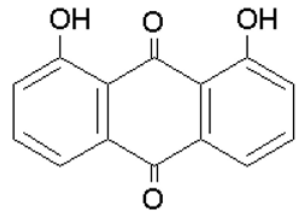
Figure 5. Structural formula of danthron.